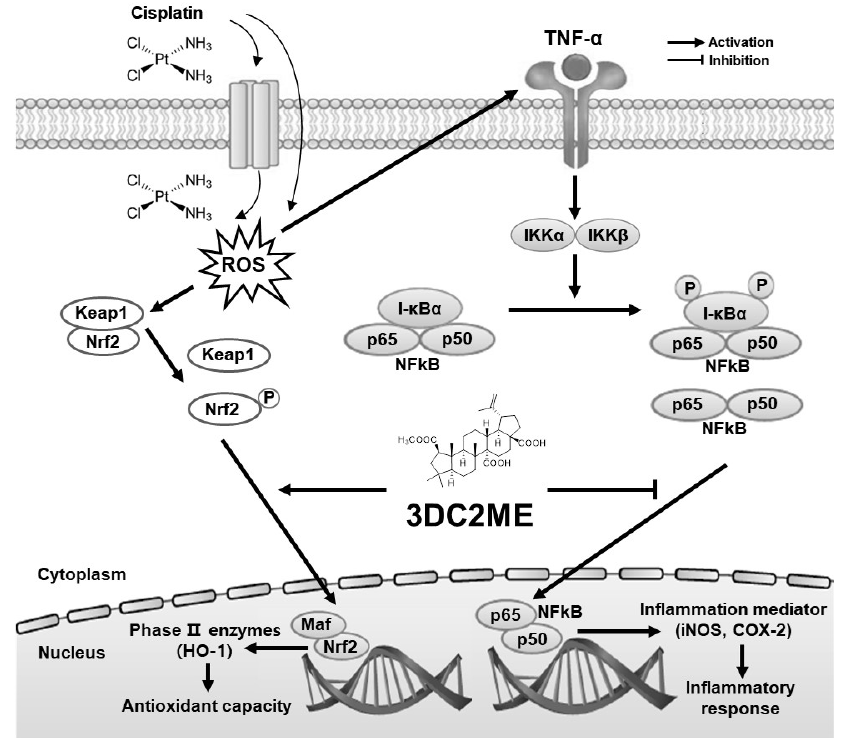
Figure 7. Schematic pathway for the potential mechanism of 3DC2ME in